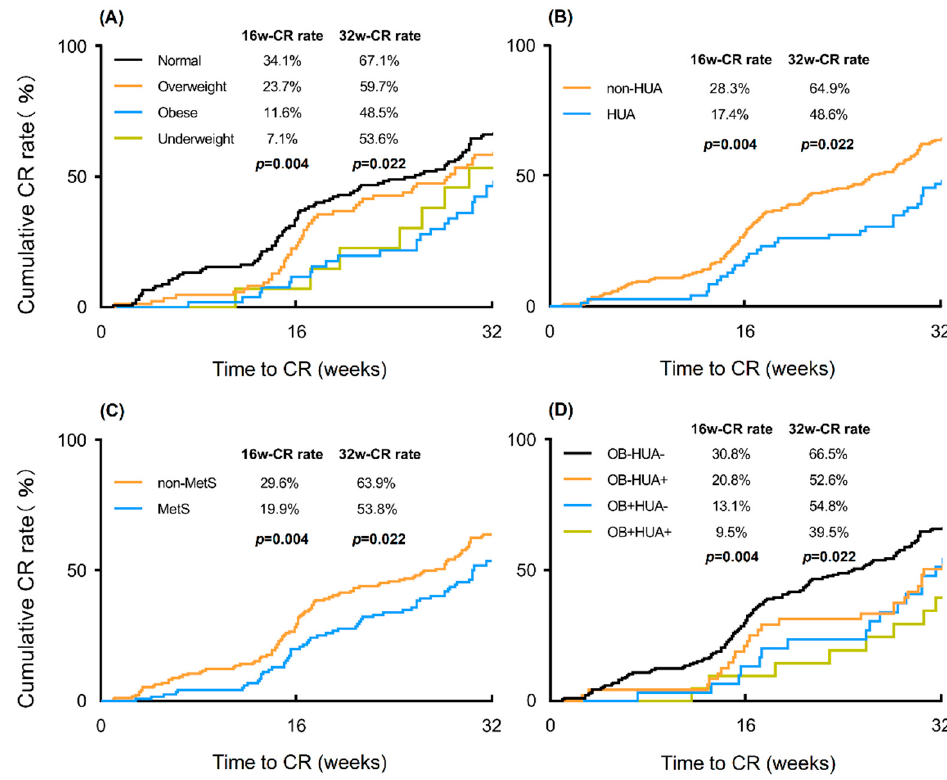
Figure 2. Cumulative CR rate at the 16th and 32nd week of treatment. ( A ) Cumulative CR rate in patients with a different weight status; ( B ) Cumulative CR rate in patients with or without HUA; ( C ) Cumulative CR rate in patients with or without PCOS; ( D ) Cumulative CR rate in patients with or without HUA stratified by obesity. Cumulative CR rate was evaluated by the Kaplan–Meier method and compared by a log-rank test. CR, complete response; HUA, hyperuricemia; PCOS, polycystic ovary syndrome; OB, obesity.